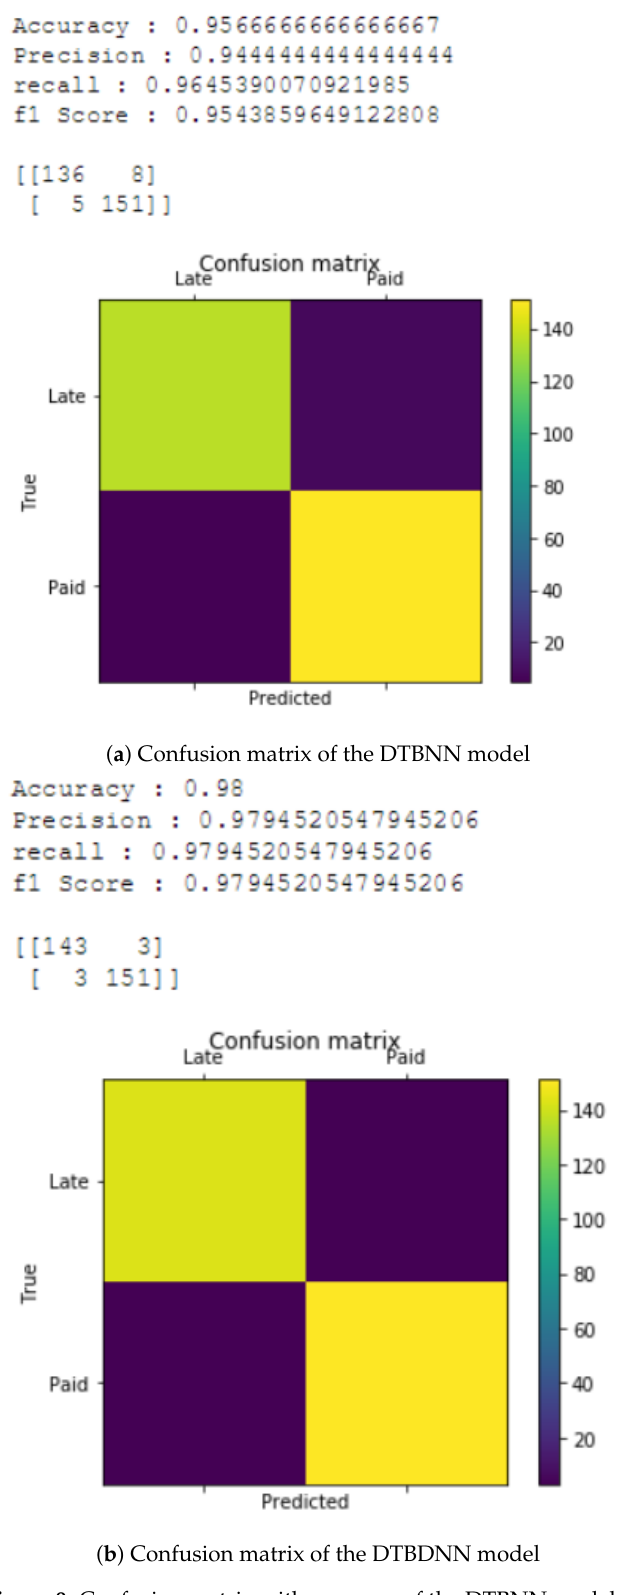
Figure 9. Confusion matrix with accuracy of the DTBNN model and DTBDNN